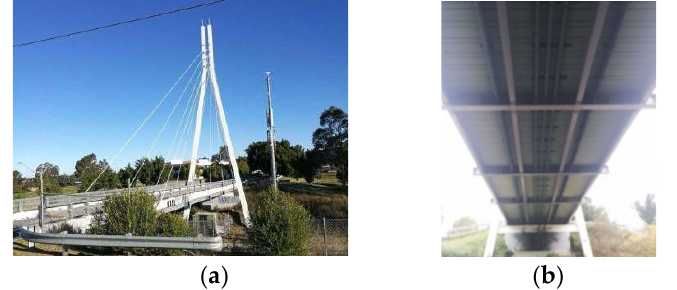
Figure 1. A single tower cable-stayed bridge. ( a ) The cable-stayed bridge; ( b ) the girder layout [1].